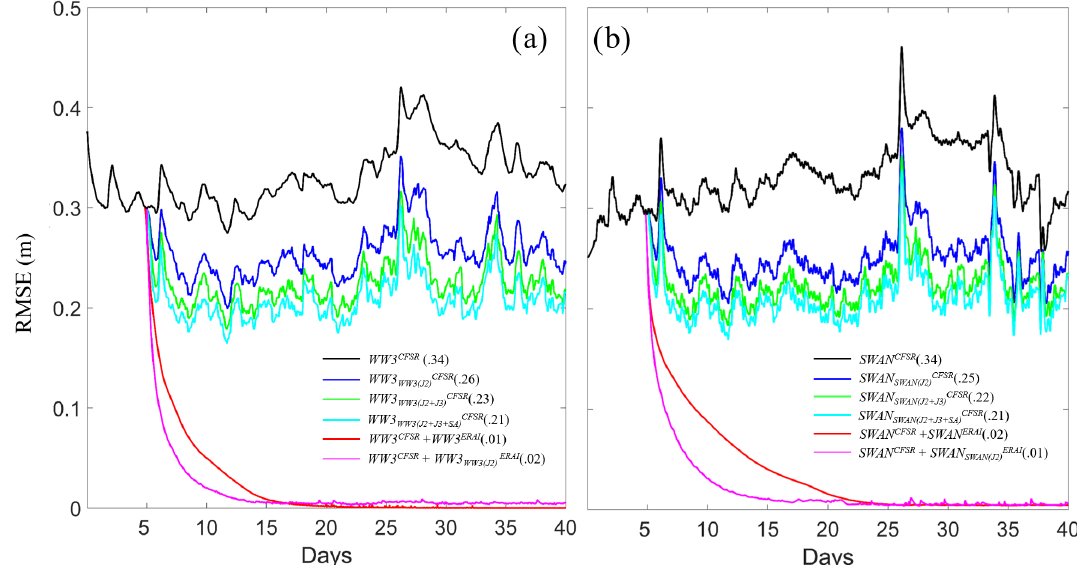
Figure 3. The time series of RMSEs of the (a) WW3 and (b) SWAN perfect model experiments in the model control run with the NCEP CFSRv2 wind (black, denoted as WW3 CFSR in panel ( a ) and SWAN CFSR in (b) , assimilating the “observed” data sampled by the tracks of Jason-2 (blue, denoted as WW3 CFSR and SWAN CFSR ), Jason-2 and 3 (green, denoted as WW3 CFSR and SWAN CFSR ), WW3(J2) SWAN(J2) WW3 ( J2 + J3 ) SWAN ( J2 + J3 ) as well as Jason-2 and 3 and SARAL (cyan, denoted as WW3 CFSR and SWAN CFSR ) against the truth simulation WW3 ( J2 + J3 + SA ) SWAN ( J2 + J3 + SA ) forced by the ERA-Interim wind. The red and pink are forced by the NCEP CFSRv2 wind in the first 45d, but the next 35d are forced using the ERA-Interim wind (same as truth) without (denoted as WW3 CFSR + WW3 ERAI and SWAN CFSR + SWAN ERAI ) or with (denoted as WW3 CFSR + WW3 ERAI and SWAN CFSR + SWAN ERAI ) the assimilation of Jason-2 data. The number in parentheses for each WW3(J2) SWAN(J2) color is the corresponding RMSE averaged globally over the verification time period (30d after the 45d model spin-up and 5d assimilation spin-up). The observed data are produced by projecting the truth SWH onto the satellite